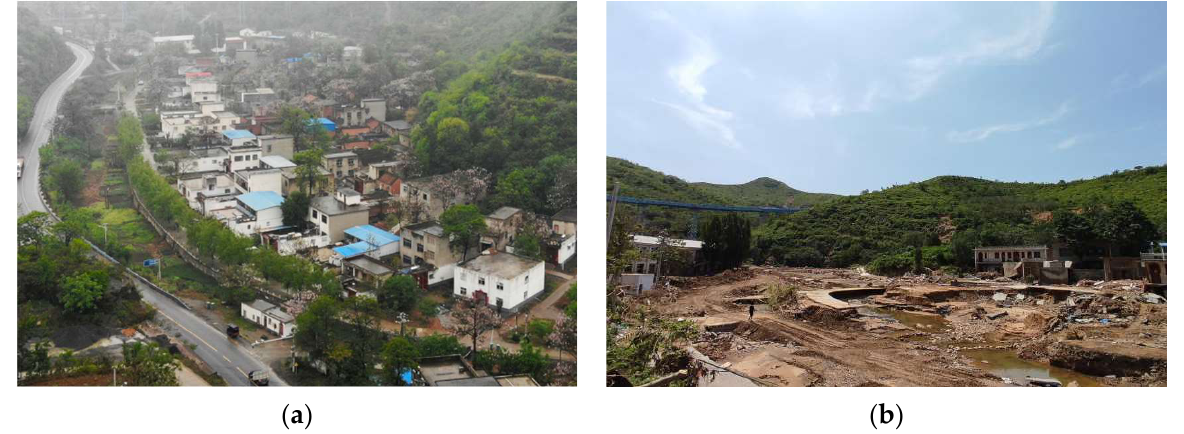
Figure 1. Comparison of before and after the “7.20” flash flood disaster in Wangzongdian Village, Henan Province. ( a ) before, ( b ) after.